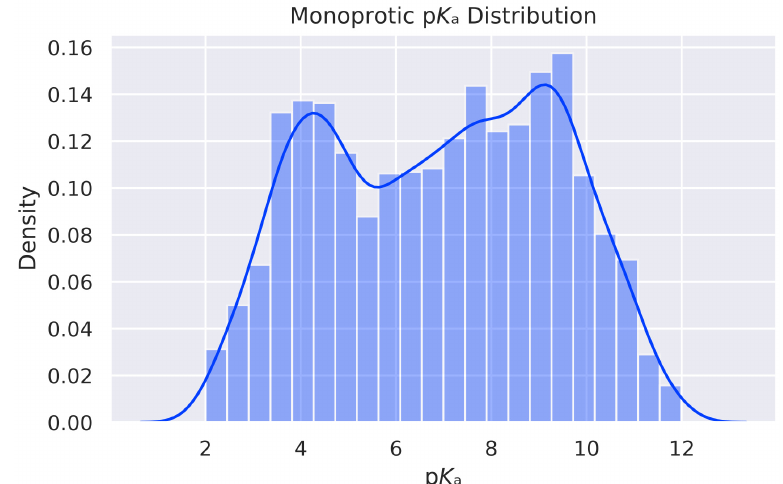
Figure 1. Distribution of the individual pK